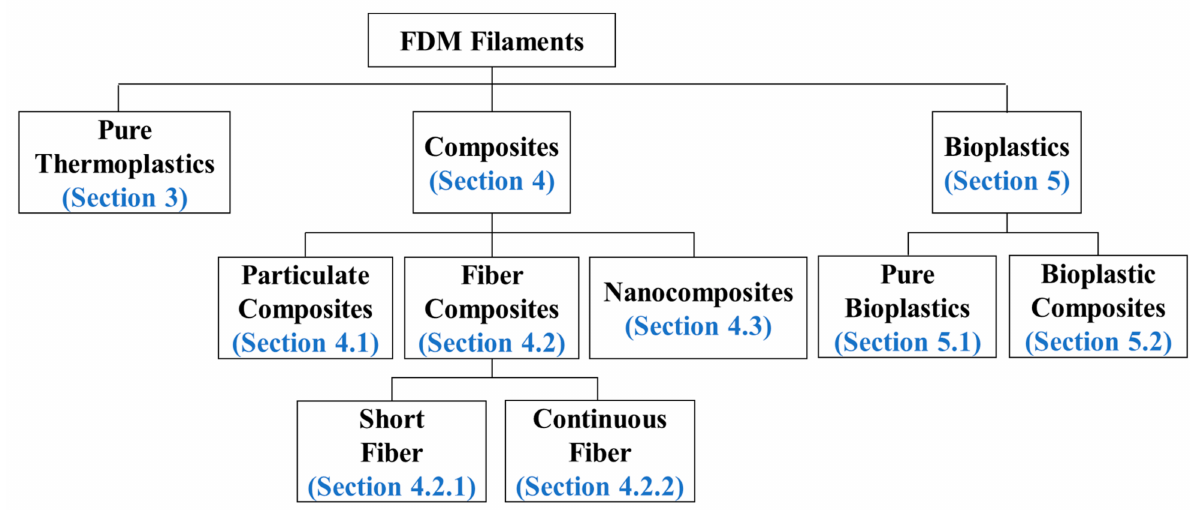
Figure 2. The category breakdown of various existing filament